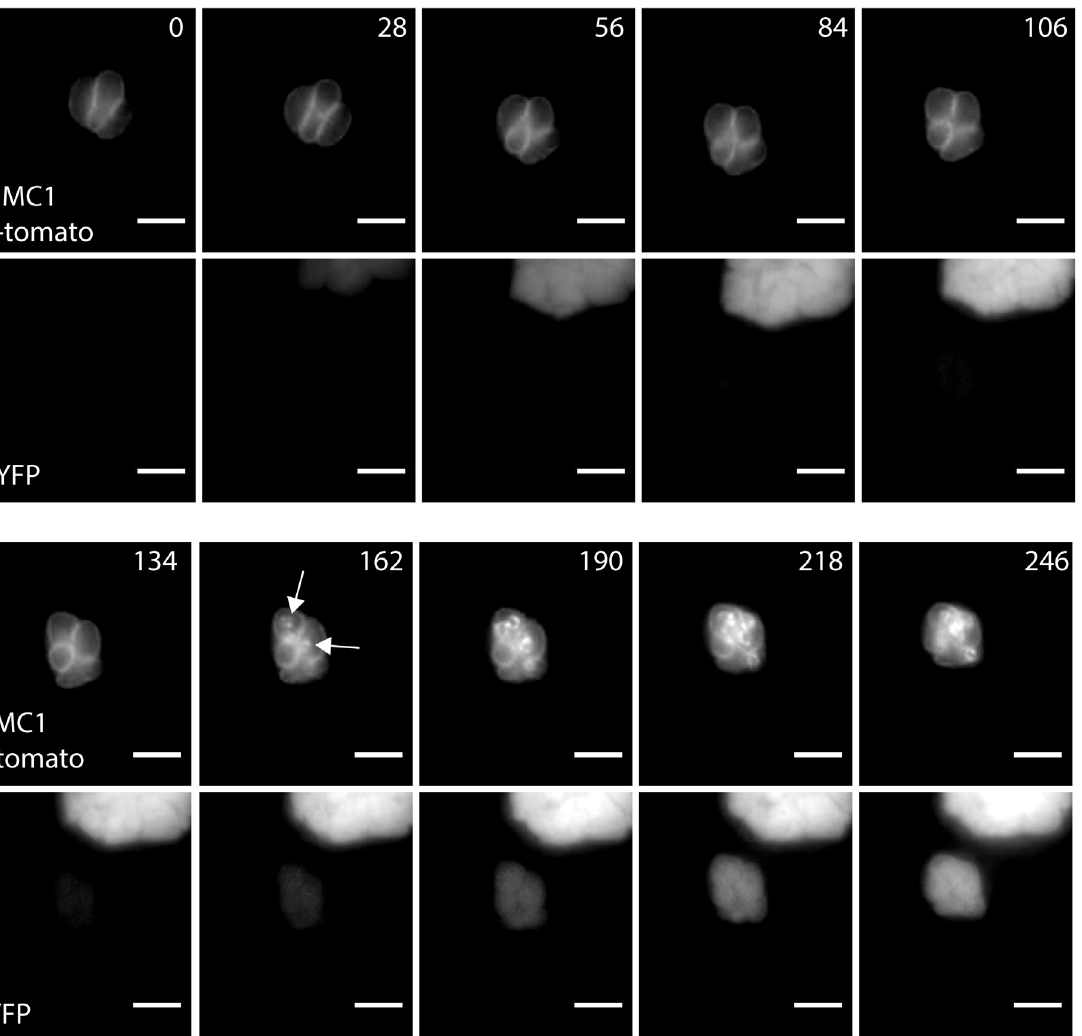
Fig 6. gap40 KOi parasites collapse after initiation of the cell cycle. Parasites were transiently transfected with imc1-tomato , allowed to express overnight before the addition of 50 nM rapamycin to induce excision of the gene. 4 hours post excision, imaging was initiated and images taken every 7 minutes, every second frame is displayed. The IMC1-expressing vacuole initiated endodyogeny at 162 min after imaging was initiated as indicated by the formation of daughter cell buds (arrows) and at the same point YFP expression was observed. Soon after the initiation of endodyogeny, the vacuole was observed to lose organization. Scale bar 5 μ